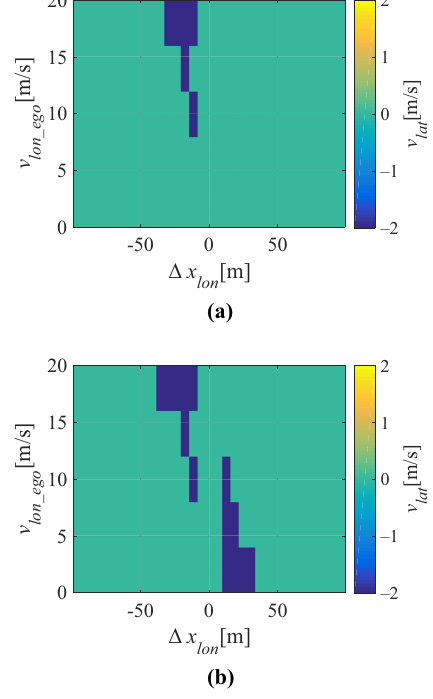
Figure 5 Comparison of the different prediction